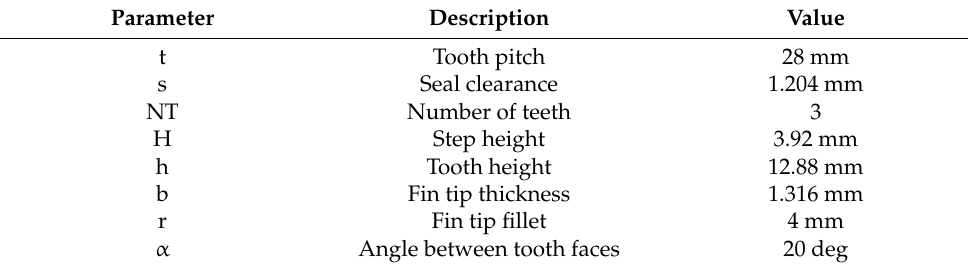
Table 2. Honeycomb cell geometrical parameters.